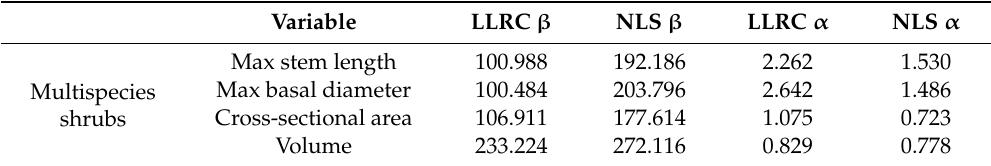
Table 3. Regression coe ffi cients for each 1D, 2D, and 3D model to predict total AGB for multispecies shrubs with LLRC and